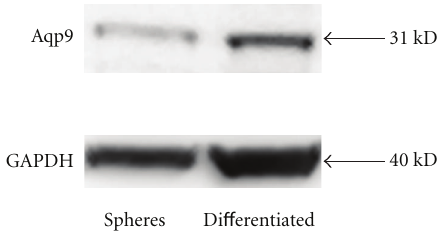
Figure 5: Western blot showing Aquaporin 9 protein expression in tumour progenitor cells (spheres) and cells di ff erentiated from them. 100 μ g of protein was loaded in each